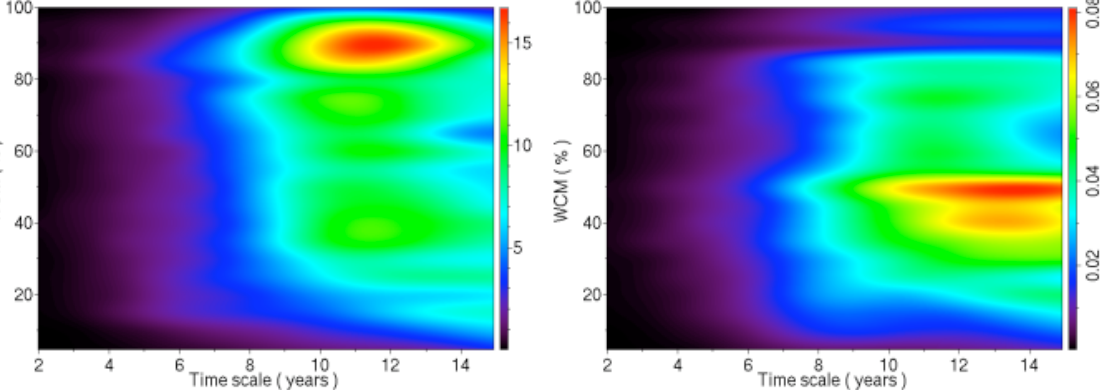
Fig. 10. Time scale spectra, WCM (%) vs. time scales of MWSI (left) and MPSI (right) for 1975–2002 (upper panel) and time scale spectra of the group sunspot number and the 14 C production rate from 1610–1950 (lower panel). BP stands for Before Present